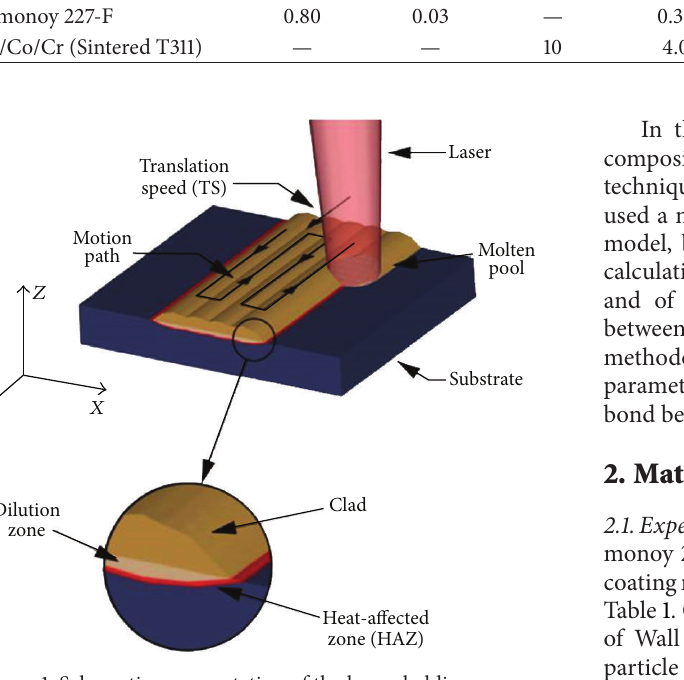
Van Acker et al. [11] explored laser cladding of Ni- WC/W 2 C MMC coatings on low carbon steel substrates, using a CO 2 laser. They made different coatings with three different particle sizes of the carbides and volume fractions ranging from 0% up to 50%. A clear dependency of the wear resistance on the carbide concentration was found, which was more pronounced for the coatings with the finest WC/W 2 C carbides. They found that a small amount of carbides is sufficient to improve the wear resistance